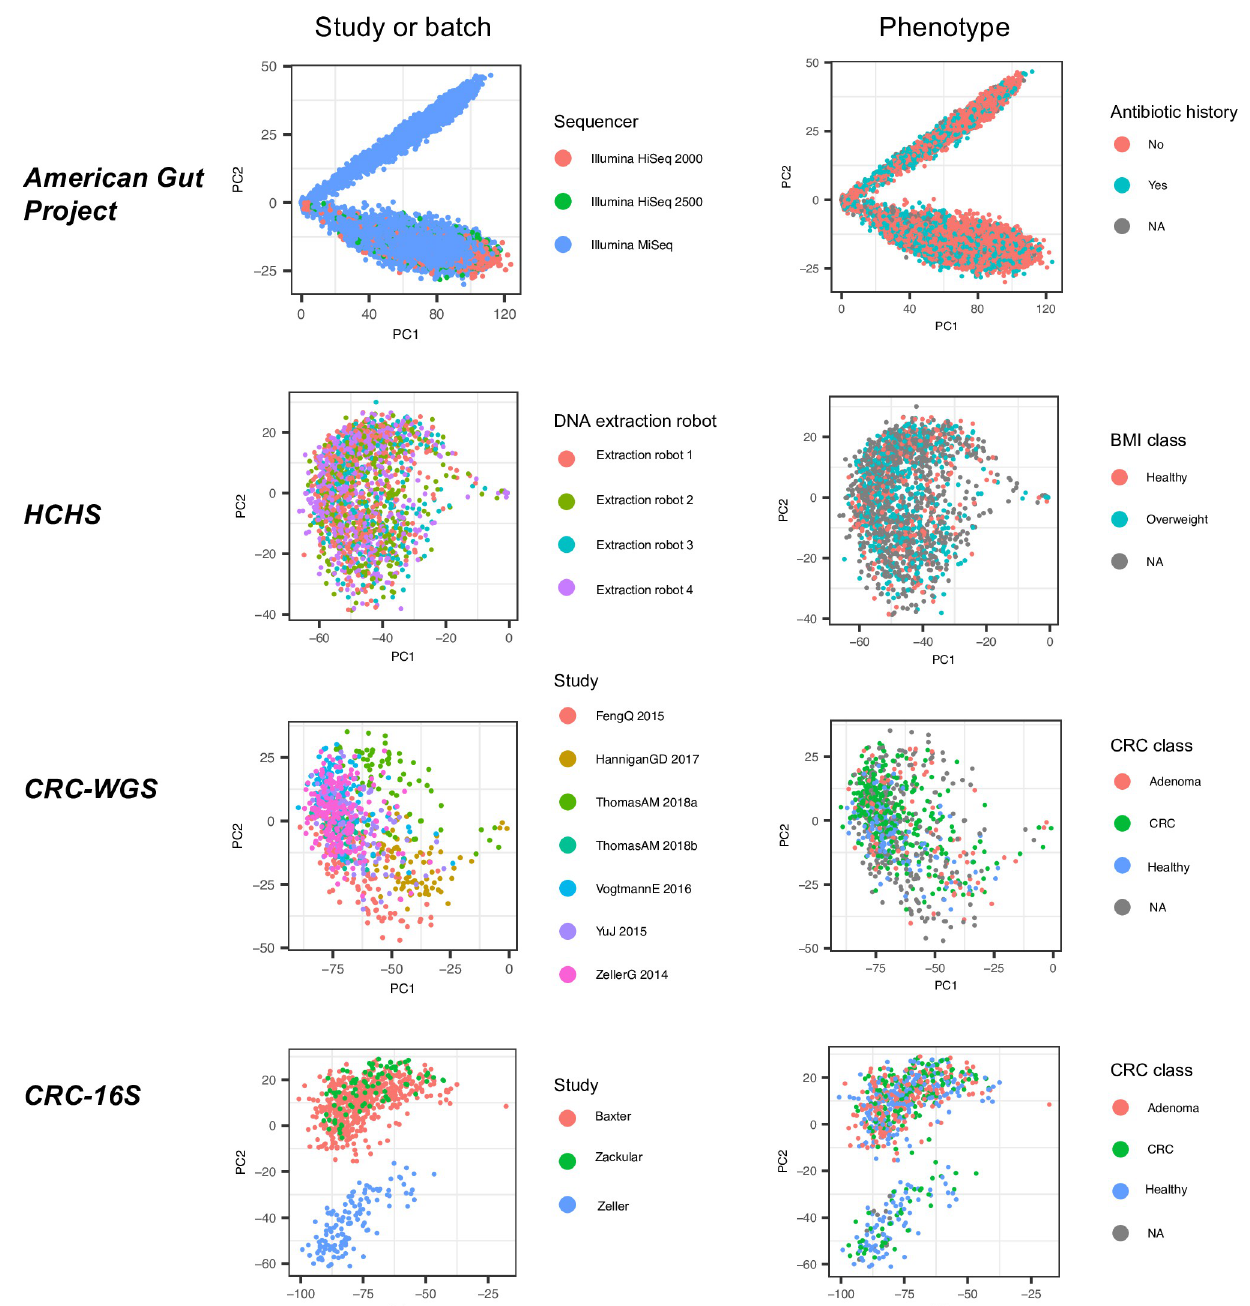
Fig 1. First two principal components of across datasets. PCA applied to CLR-transformed taxonomic abundance data from the four datasets of the study. Each point represents a single microbiome sample colored by either study or batch and by phenotype group. https://doi.org/10.1371/journal.pcbi.1009838.g001 We also assessed the impact of k -merization on the correlation of variables with top PCs. Unlike for taxonomic abundances, CRC-WGS does not show significant change as a result of CLR transformation on k -mers (S5 Fig). In the AGP dataset, median correlations with BMI and antibiotic history increase from 0.55 to 0.57 (Wilcoxon signed-rank p-value = 8 x 10 − 4 ),